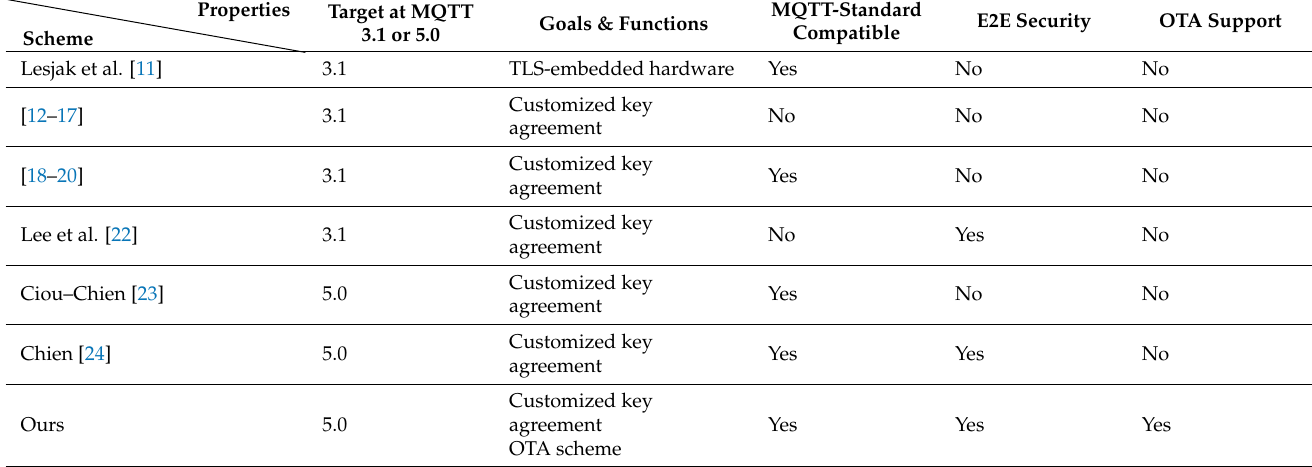
Table 1. Summary of related